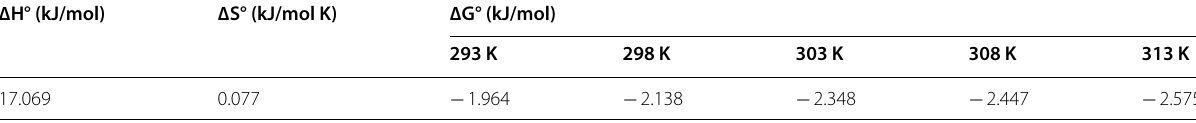
Table 4 Thermodynamic parameters for the removal of MG from aqueous solution by TLLP ∆H° (kJ/mol) ∆S° (kJ/mol